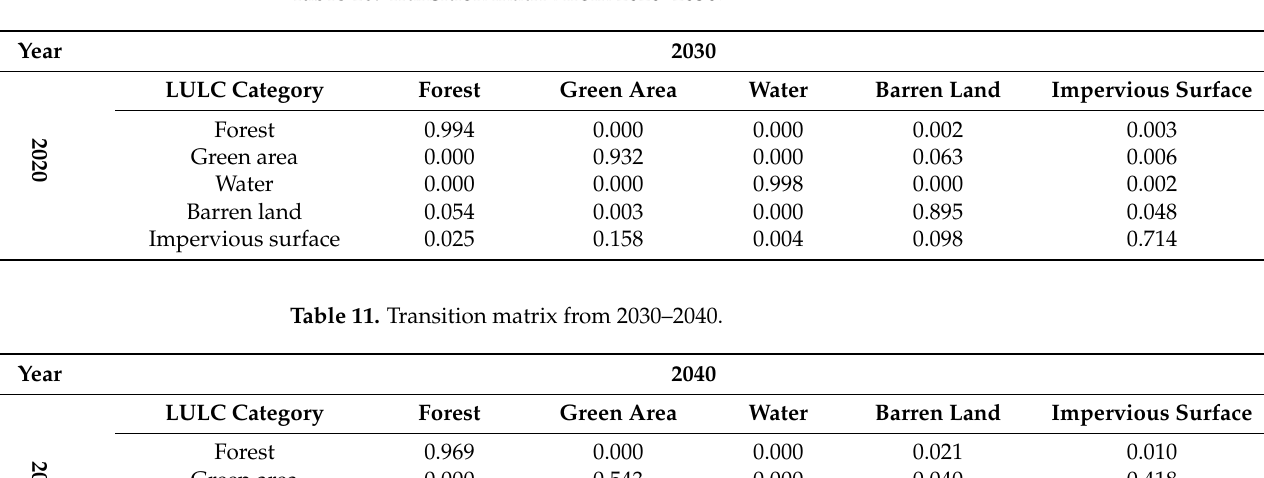
Table 10. Transition matrix from 2020–2030.